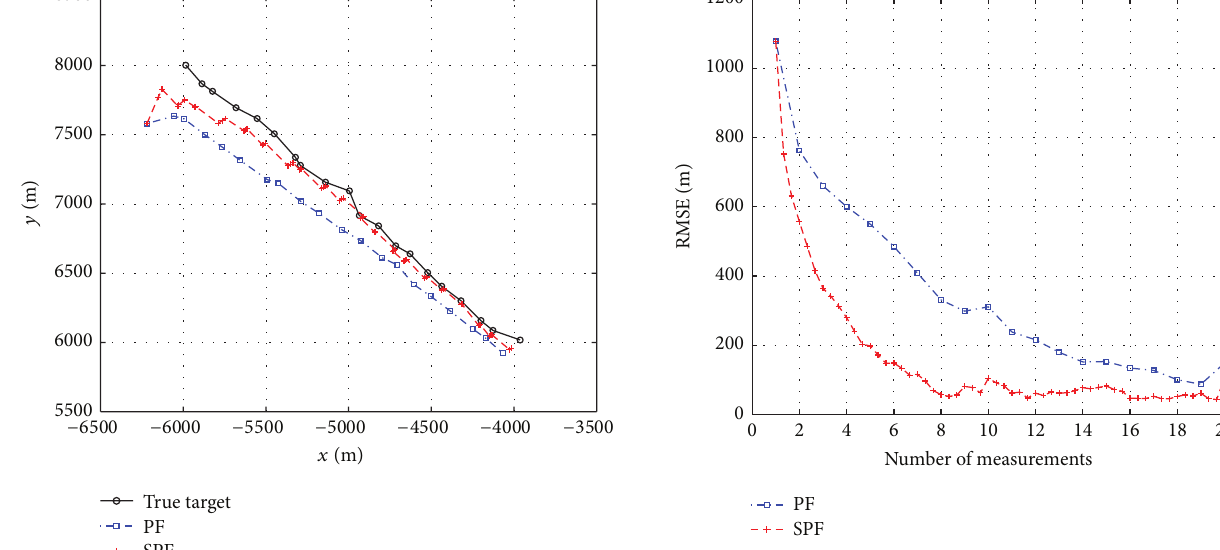
Figure 9: Tracking trajectories of PF and SPF methods against true target (20MC trials).